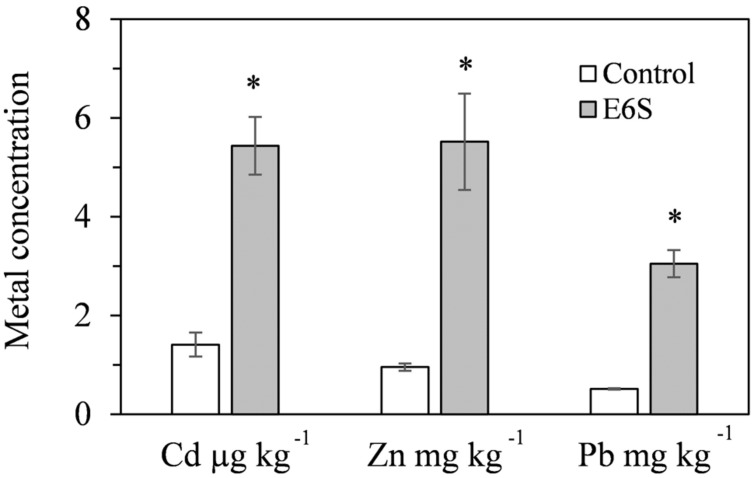
Effect of inoculation with E6S on the mobilization of Cd, Zn, and Pb in soil. Bars represent standard deviations of triplicates. An asterisk (∗) denotes a value significantly greater than the corresponding control value according to Student’s t-test (p < 0.05).